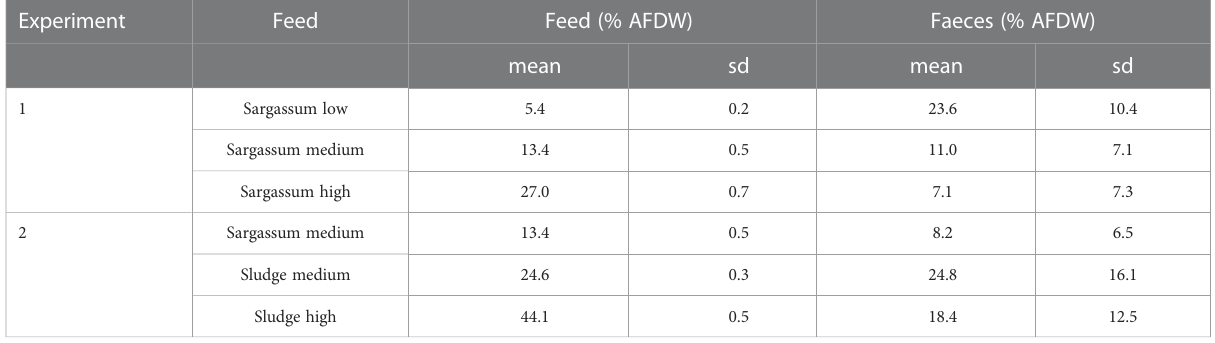
TABLE 4 Content of organic matter (% ash-free dry weight, AFDW) in experimental feeds and faeces from Parastichopus tremulus (sd, standard deviation). Experiment